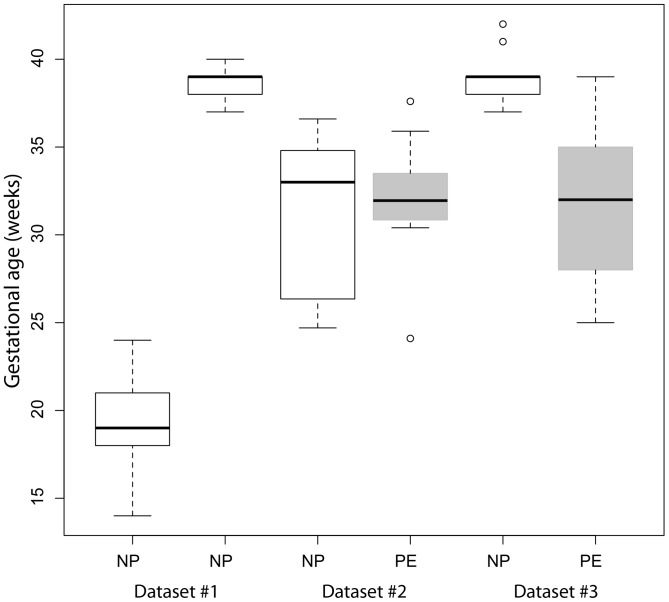
Distribution of gestational ages in the three datasets.The figure shows the median, 1st and 3rd quantile, range of the data and outliers. The grey boxes represent the preeclamptic cases (PE) and white boxes represent normal pregnancies (NP).